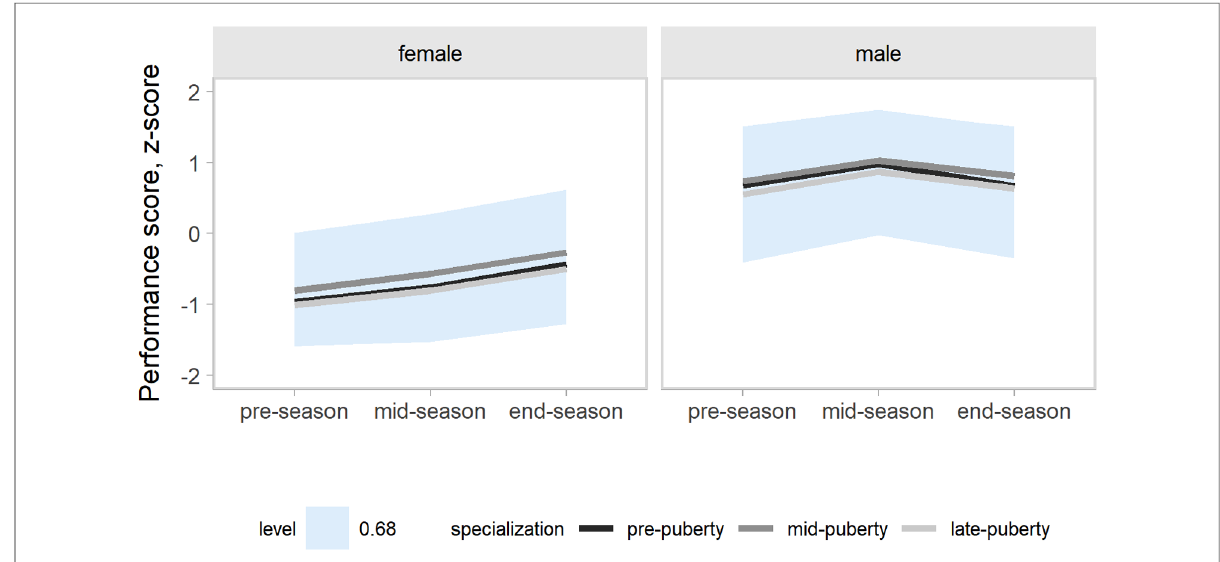
FIGURE 4 Changes in overall basketball-speci fi c physical fi tness index for young females and male basketball players within a basketball season by the onset of specialization. The shaded area represents the 68% credible interval, similar to a standard